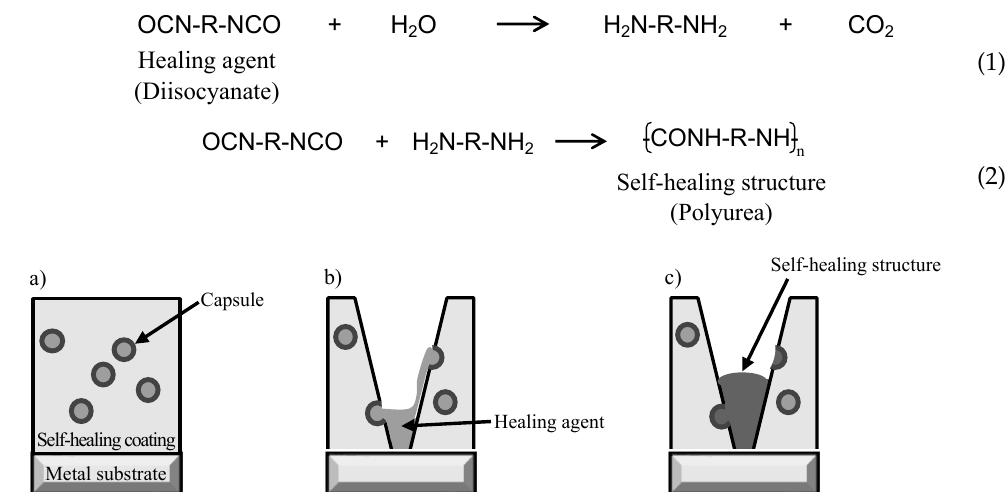
Figure 1. Schematic illustration of self-healing coating with dispersed capsules containing a healing agent. ( a ) Self-healing coating after aging. ( b ) Damage to coating caused by a cu tt er blade and the fl owing out of the healing agent. ( c ) Formation of the self-healing structure through the reaction of the healing agent with moisture in the air. The self-healing structure covers the exposed area of the metal substrate and the cor- rosion protection of the metal substrate is maintained at a high level after damage to the coated layer. According to the self-healing mechanism of the coating, the self-healing ability of this coating heavily depends on the shape, size, and structure of the capsules dispersed in the coating. The capsule containing a healing agent can be synthesized by the process shown in Figure 2. First, the organic solvent solution of the prepolymer is synthesized by reacting diisocyanate with polyol, as shown in Equation (3).